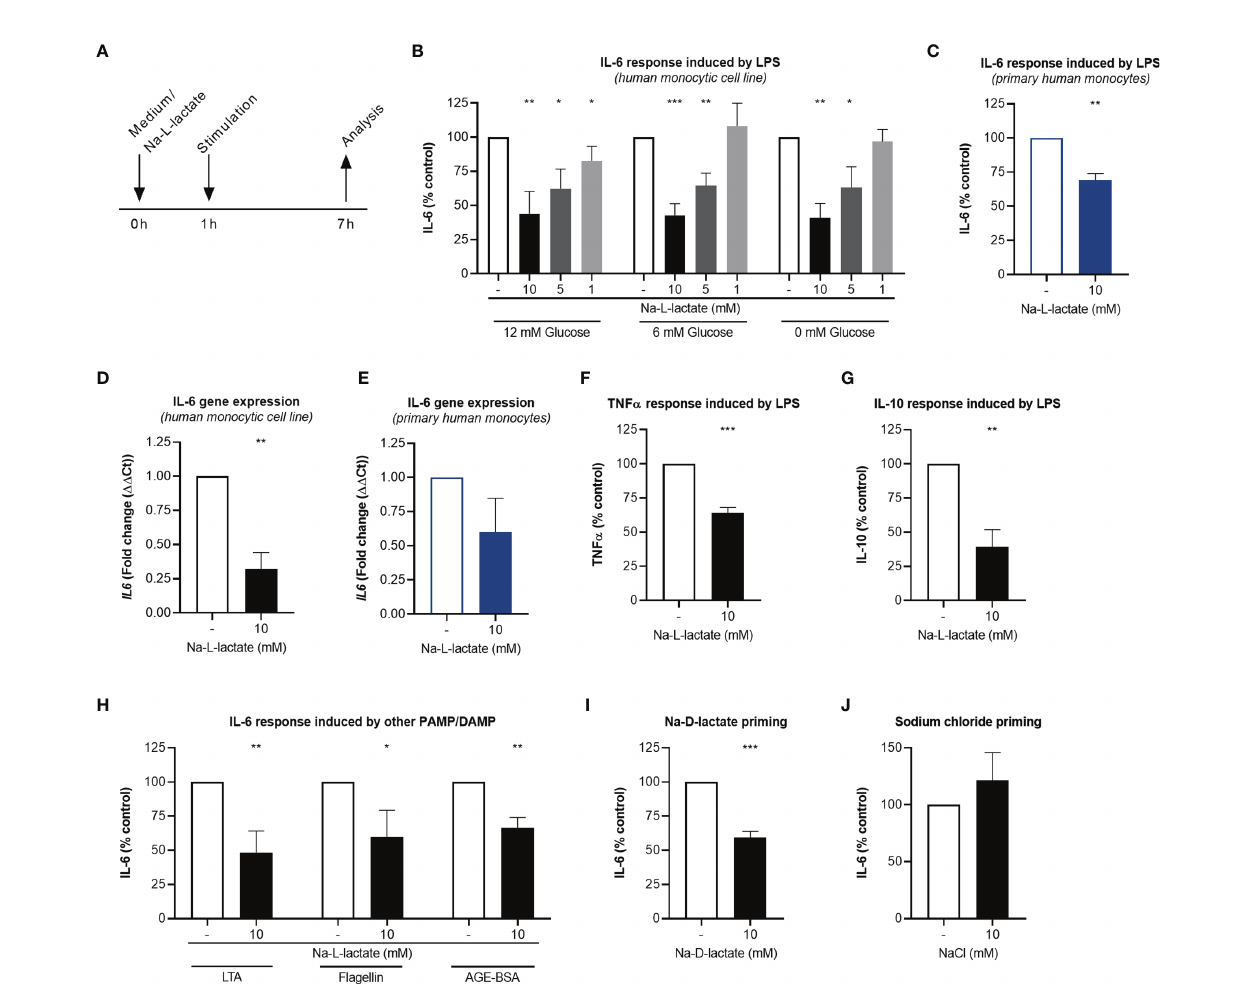
FIGURE 1 | Extracellular lactate reduces cytokine response upon stimulation. (A) Time scale of the analyses. (B) IL-6 secretion from MM6 primed with Na-L-lactate at the indicated concentrations for one hour and stimulated with LPS for six hours in medium with 12mM, 6mM, or without glucose. (C) IL-6 secretion from primary human monocytes primed with 10mM Na-L-lactate for one hour and stimulated with LPS for six hours. Gene expression of IL6 in MM6 (D) and primary human monocytes (E) after one-hour priming with 10mM Na-L-lactate and six hours stimulation with LPS. (F) TNF a and (G) IL-10 secretion from MM6 primed with 10mM Na-L-lactate for one hour and stimulated with LPS for six hours. (H) IL-6 secretion from MM6 after one-hour priming with 10mM Na-L-lactate and stimulation with LTA, fl agellin, or AGE-BSA for six hours. IL-6 secretion from MM6 primed with 10mM (I) Na-D-lactate or (J) NaCl for one hour and stimulated with LPS for six hours. Data are shown as mean + SD (n=4; except for (C) and (E) n=3). One sample t test was performed against the theoretical value 100 or 1 respectively (*** P ≤ 0.001, ** P ≤ 0.01, * P ≤